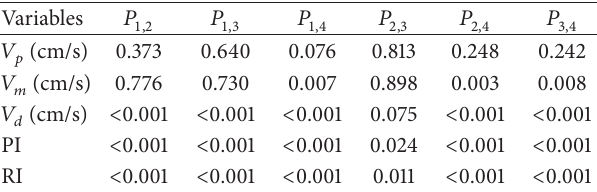
Table 5: Pairwise comparison of TCD before